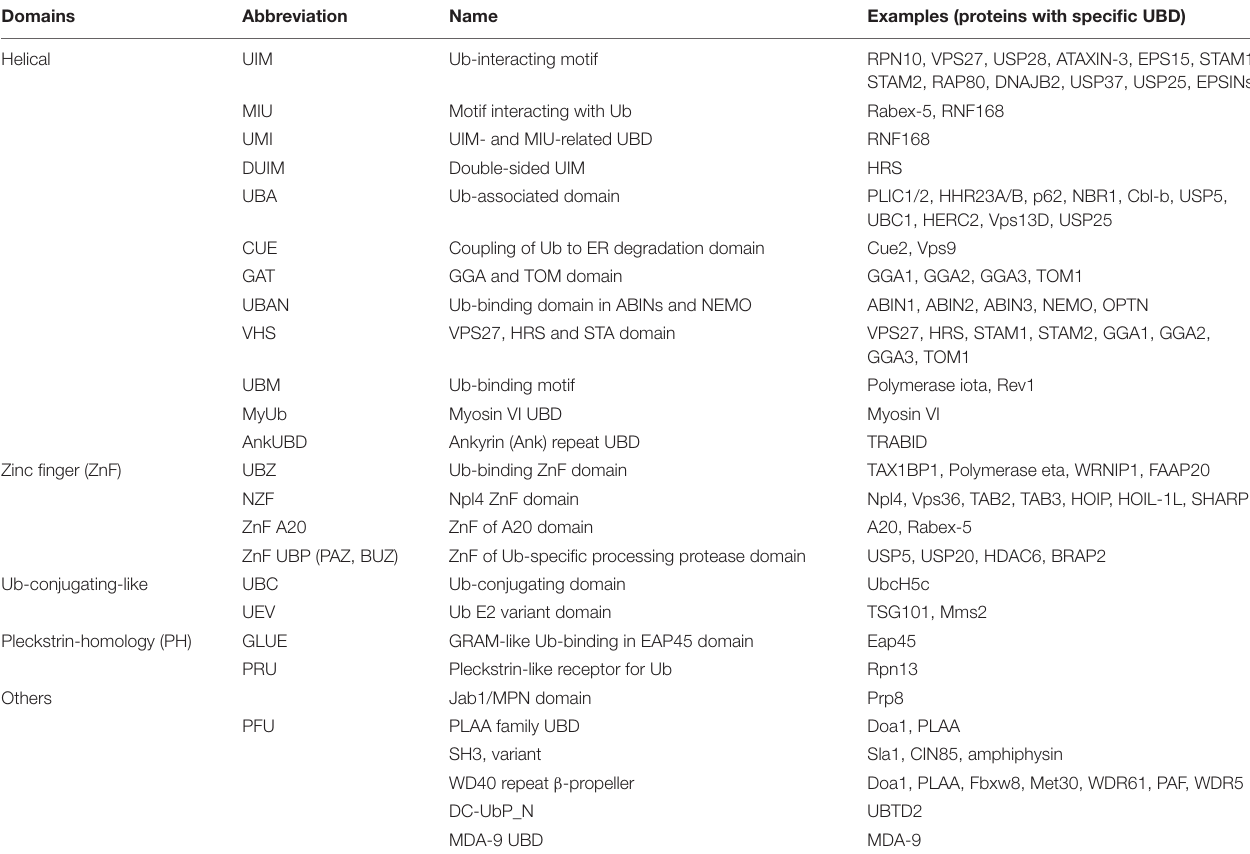
TABLE 1 | List of currently known ubiquitin-binding